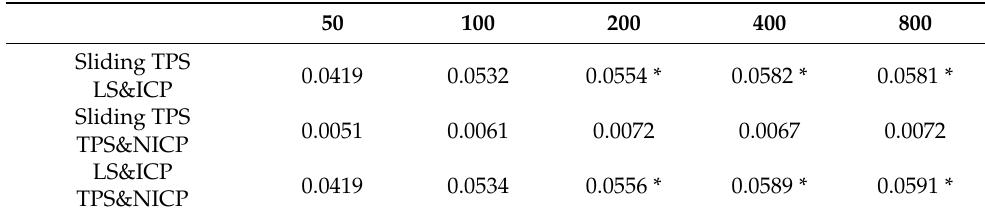
Table 3. Procrustes distance (permutation test p < 0.05 *) between mean landmark and semilandmark configurations derived at varying densities.